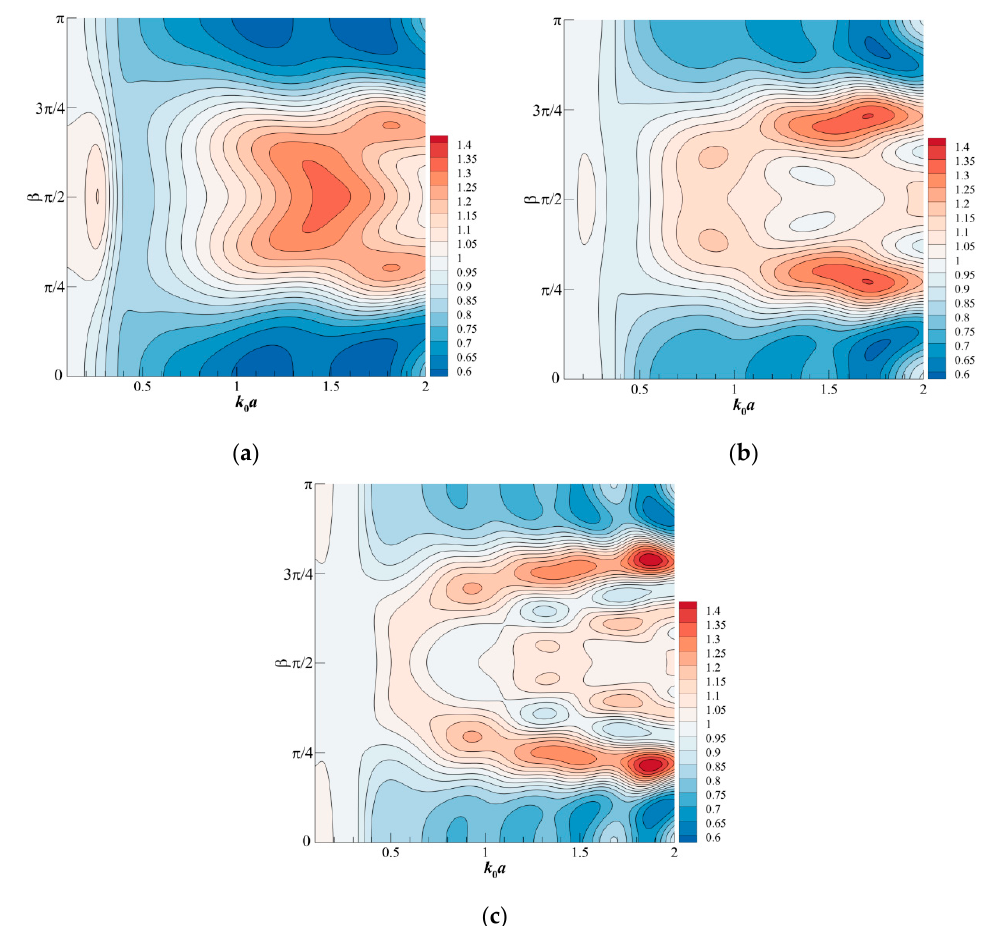
Figure 9. Contour plots of the interaction factor q for arrays composed of two 5 ‐ DOF WECs with different inter ‐ buoy spacing L : ( a ) L = 3 a ; ( b ) L = 5 a ; ( c ) L = 8 a . different inter-buoy spacing L : ( a ) L = 3 a ; ( b ) L = 5 a ; ( c ) L = 8 a